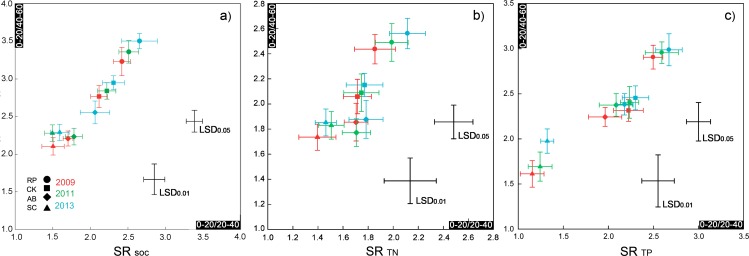
Stratification ratios of SOC, TN, and TP of different land use types and soil depth in 2009, 2011, and 2013.Abscissa and ordinate value is the stratification ratios of each symbol in 0–20:20–40cm and 0–20:40–60cm, respectively. Symbols with different shape represent different land use types: roundness is RP, square is CK, rhomb is AB and triangle is SC. Symbol with different color represent different experiment year: red for 1999, green for 2011 and blue for 2013. Bars across the symbol represent standard errors. Cross LSD shows its magnitude (at P < 0.05 or 0.01) in horizontal and vertical to compare means for stratification ratios of different land use types and years in 0–20:20–40cm and 0–20:40–60cm.